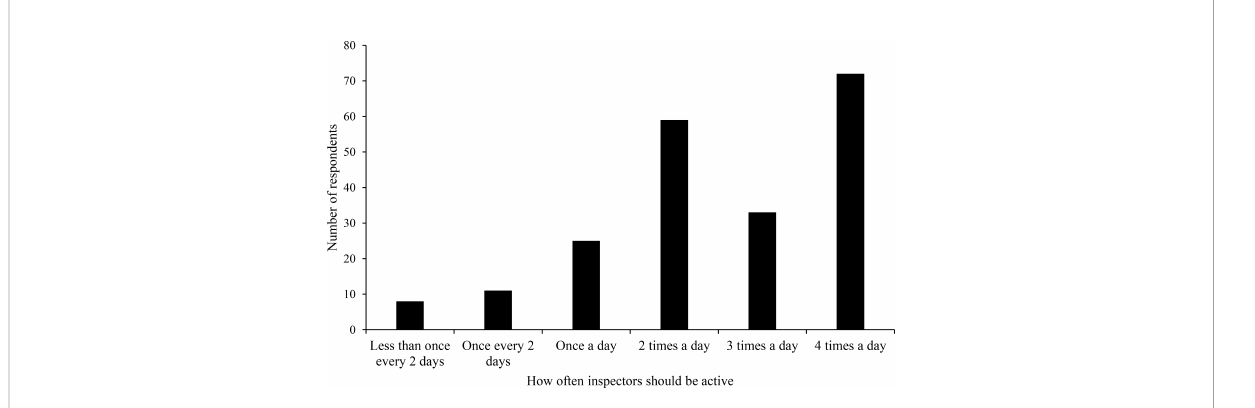
FIGURE 3 How often fi sheries inspectors should be active according to Peel-Harvey blue swimmer crab fi shers. Note: 208 respondents answered the question. Respondents were only able to select one